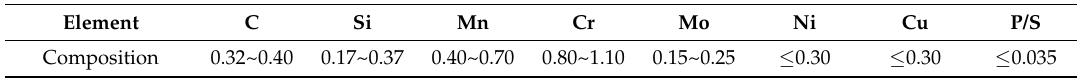
Table 1. Chemical composition of 35CrMo steel.